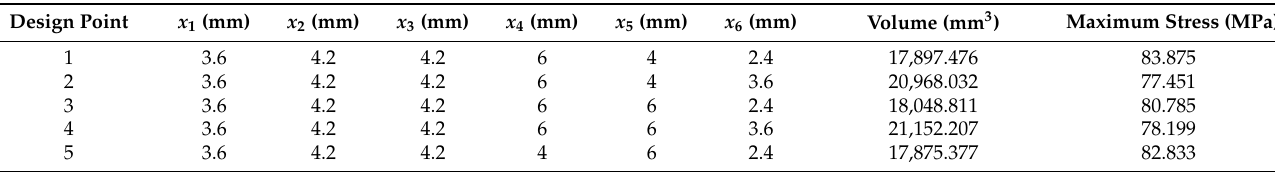
Table A1. Design points with volume and maximum